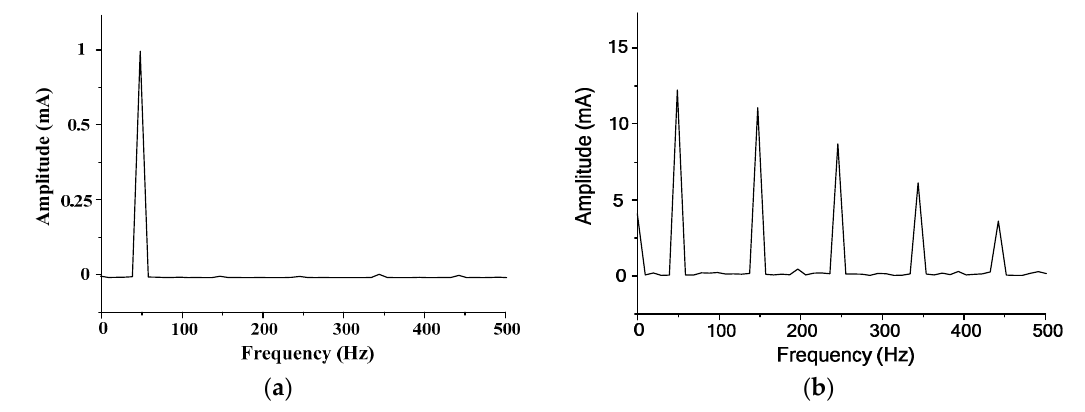
Figure 11. Frequency spectra of the leakage current. ( a ) U = 5.8 kV; ( b ) U = 17.4 kV.